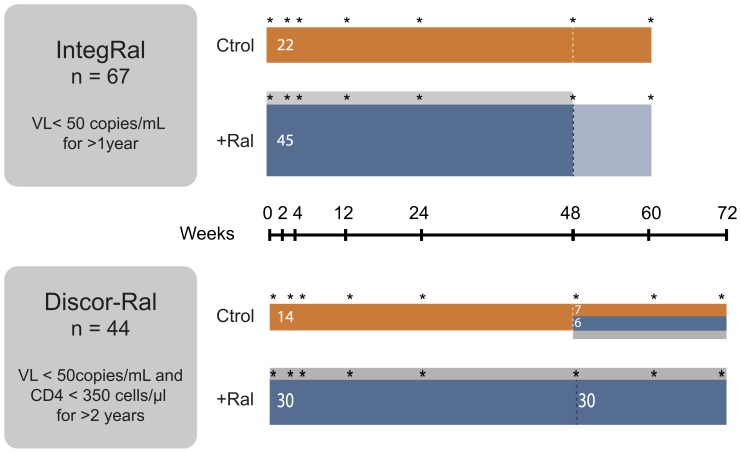
Schematic representation of IntegRal and Discor-Ral studies.In both studies, enrolled individuals were randomized 1∶2 to continue with previous cART (Ctrol, control groups in orange) or intensify their therapy with raltegravir (+Ral, intensified groups in blue). The extent of raltegravir intensification was 48 weeks for the IntegRal study and 72 weeks for the Discor-Ral study (grey areas). The follow up of the IntegRal study was 60 weeks, allowing for the analysis of the effect of raltegravir discontinuation. In the Discor-Ral study six patients from the control arm started raltegravir for 24 weeks (blue area). In all groups, asterisks denote sampling times.